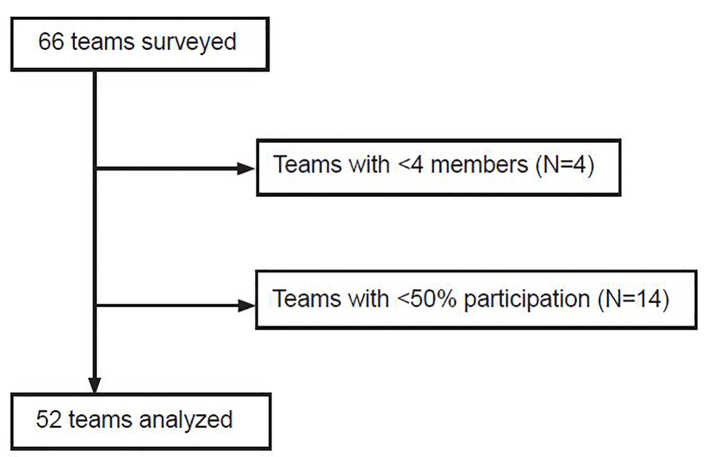
Flow diagram of trauma teams’ eligibility to be included in study analysis.